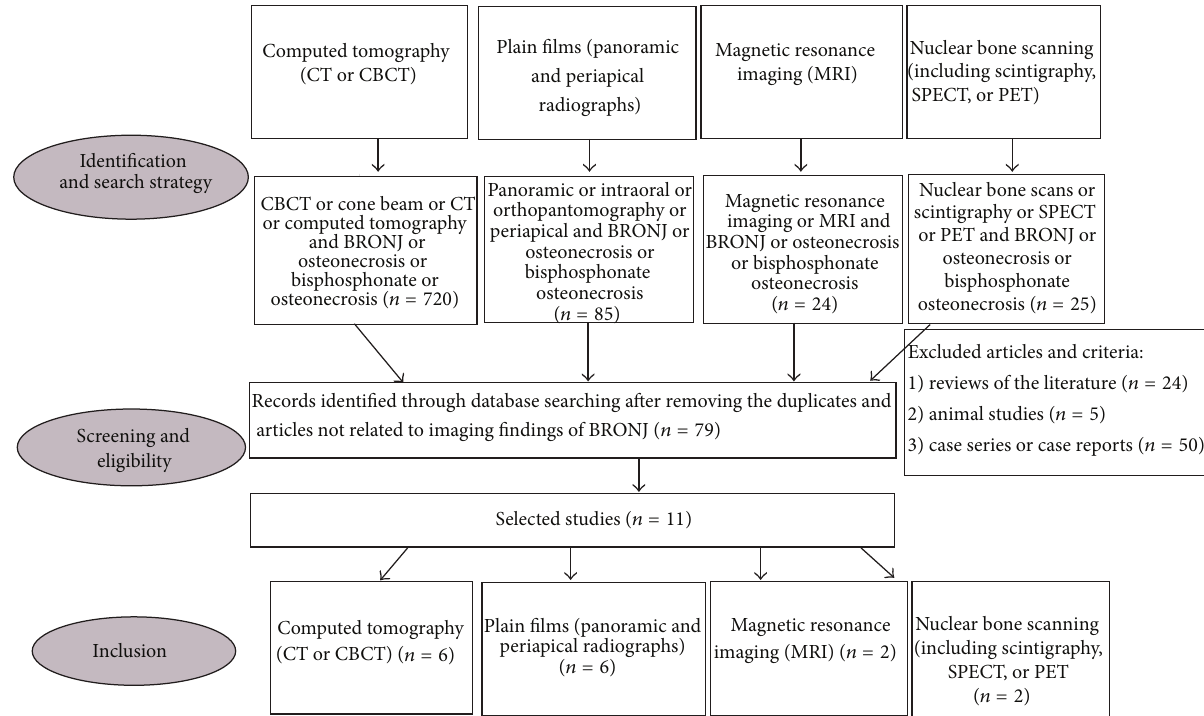
Figure 1: Flow chart of the study selection